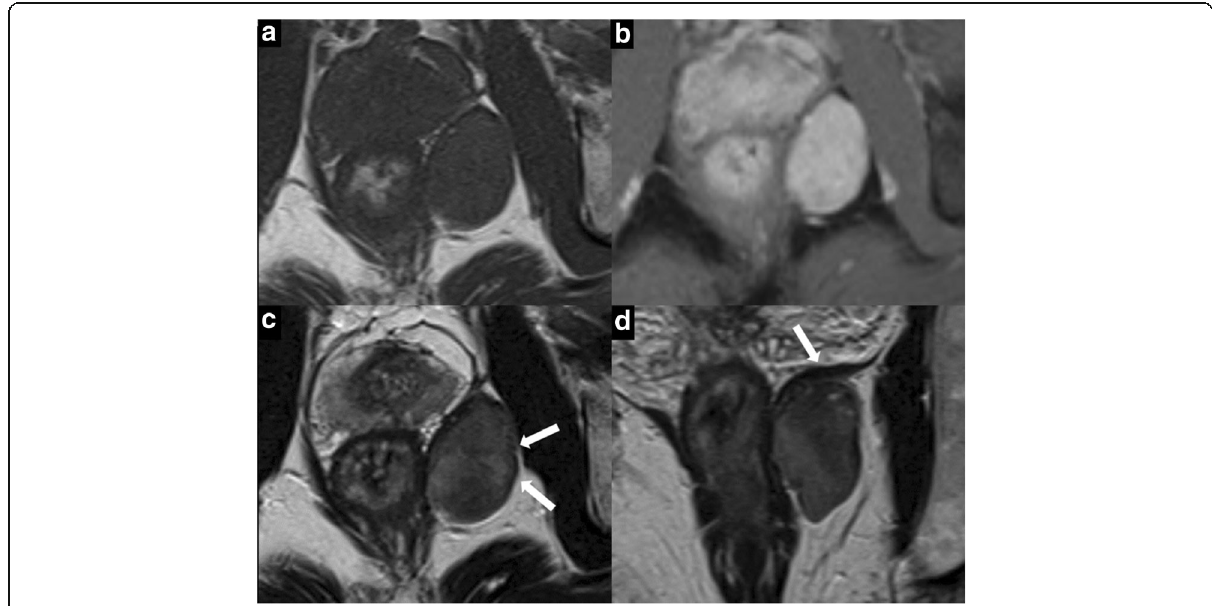
Fig. 2 MRI findings. a Axial T1-weighted image shows homogenous intermediate signal intensity. b Gadolinium contrast-enhanced fat-suppressed T1-weighted image (4 min after contrast material injection) shows homogenous enhancement. c Axial T2-weighted image shows heterogeneous